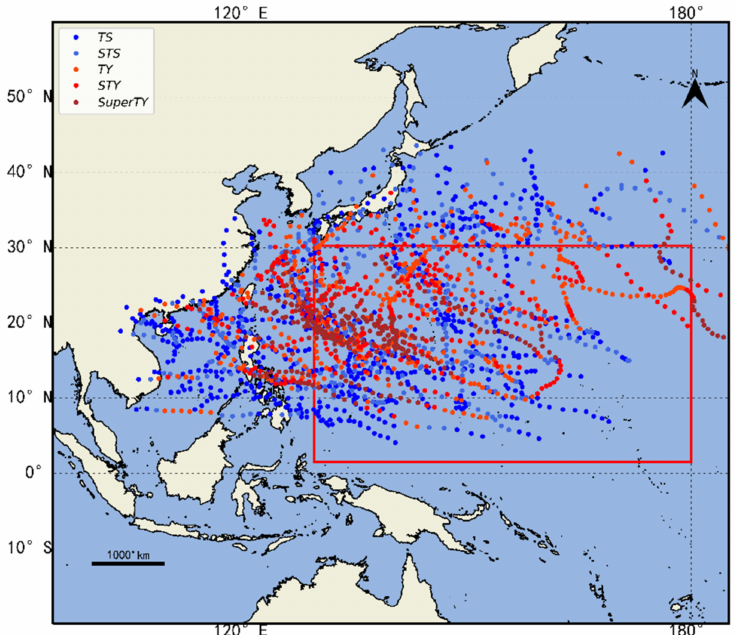
Figure 1. Bounding box (red box) of ERA5 for model construction and targeted TC tracks. TS: Tropical